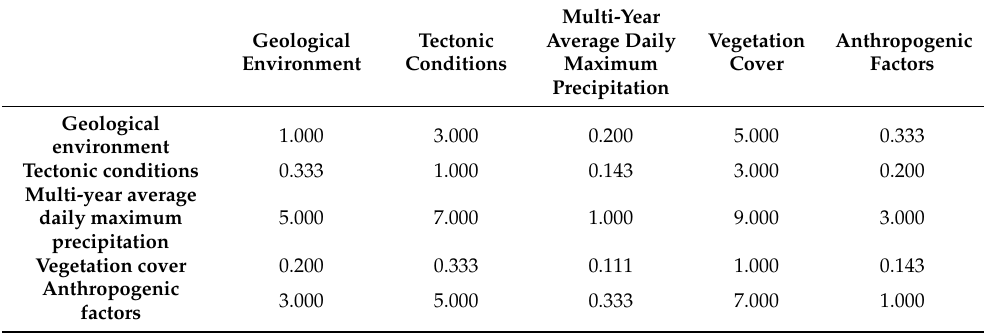
Table 3. AHP Judgment Matrix.